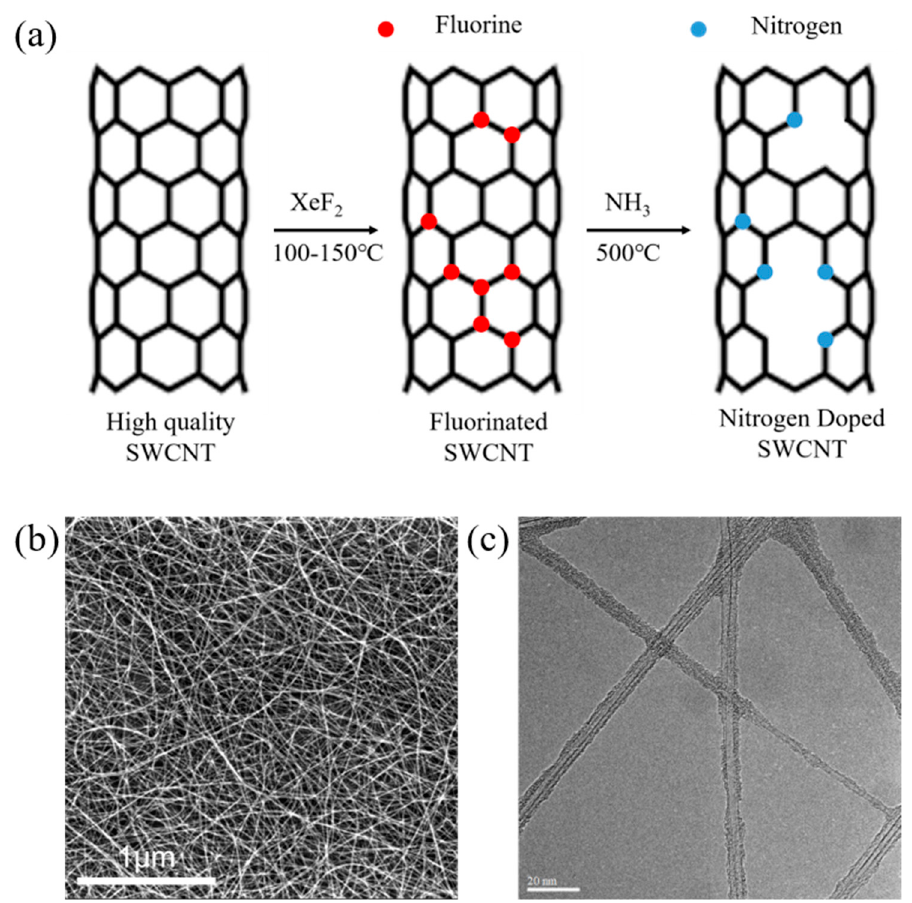
Figure 1. ( a ) Schematic showing the N–doping process of SWCNTs. ( b ) Typical SEM image of